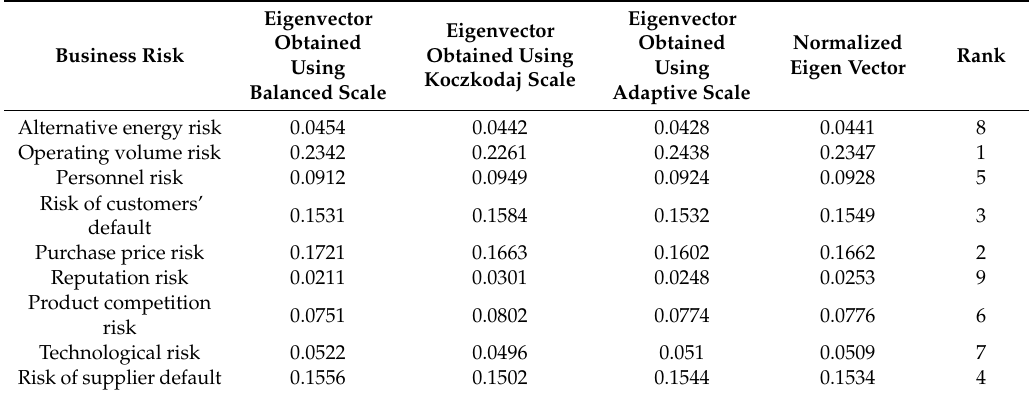
Table 2. Results of ranking the